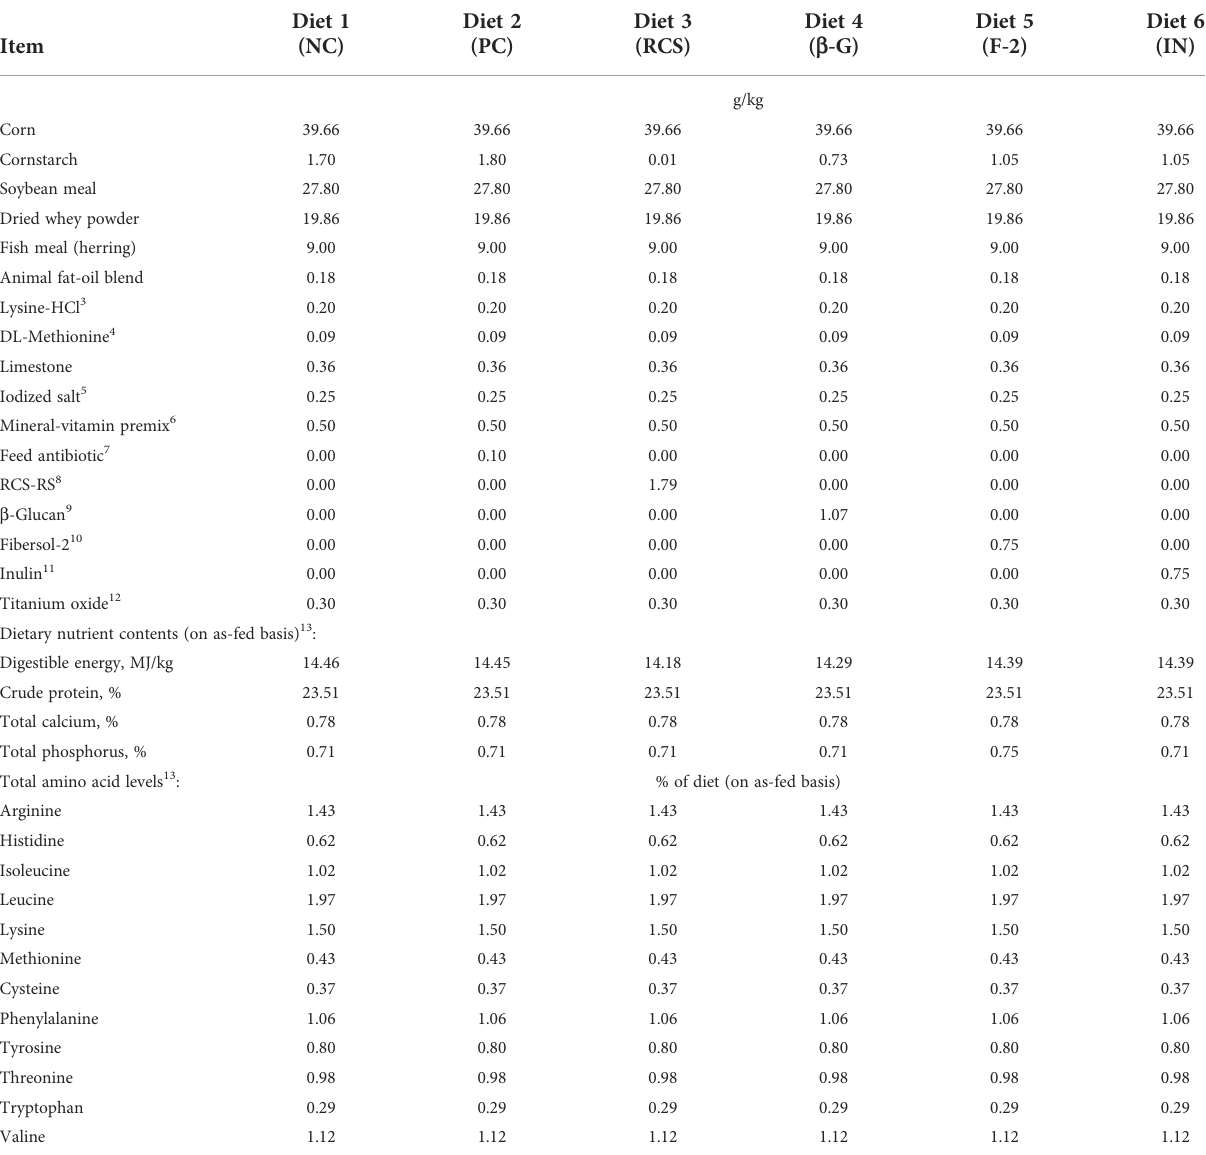
Experimental diets 2